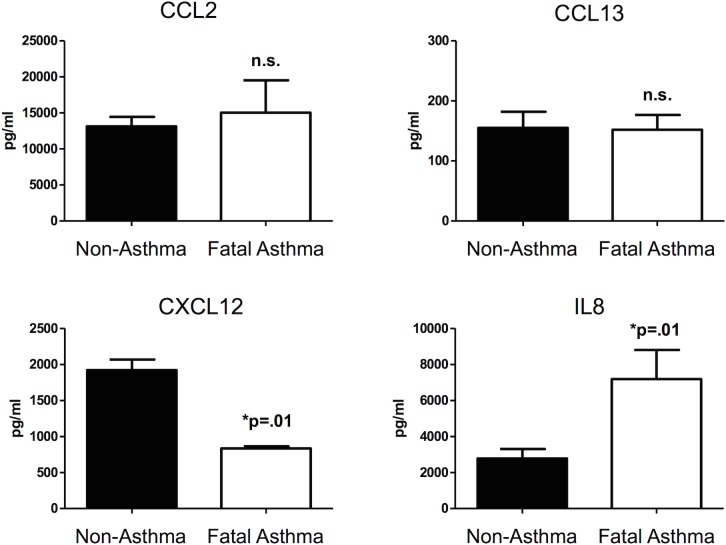
TNFα-induced cytokine levels in ASM.Cytokine levels in supernatant obtained from ASM derived from fatal asthma and non-asthma donors were determined by single ELISA. The data represent means ± standard error from ASM cells of 3 fatal asthma and 3 non-asthma donors for CCL2 and CXCL12; 5 fatal asthma and 6 non-asthma donors for CCL13; and 5 fatal asthma and 5 non-asthma donors for IL8 (numbers based on availability of cells used after RNA-Seq experiments). Each observation was performed in triplicate. Statistical significance was determined by Student’s one-tailed t-test with significance determined at p<0.05.